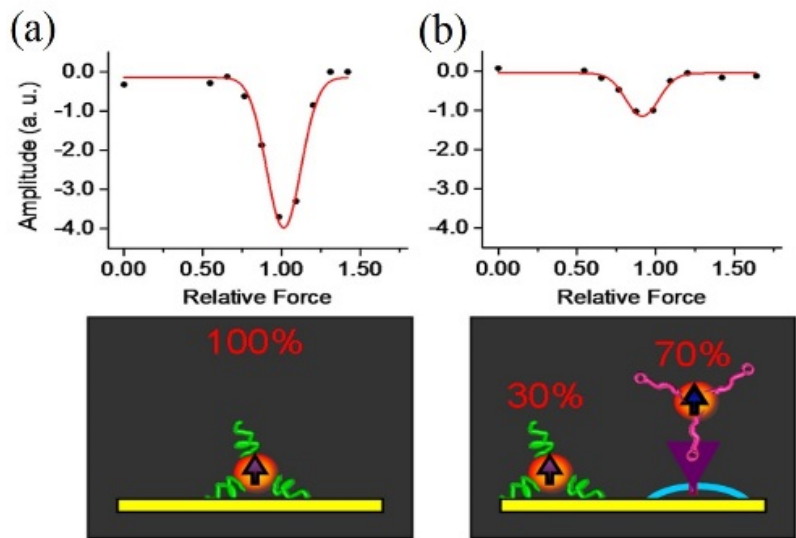
Figure 3. FIRMS spectra showing the magnetization differential as a function of disturbing force for ( a ) the blank and ( b ) cell-binding experiment [26]. Reproduced with permission from Wiley.